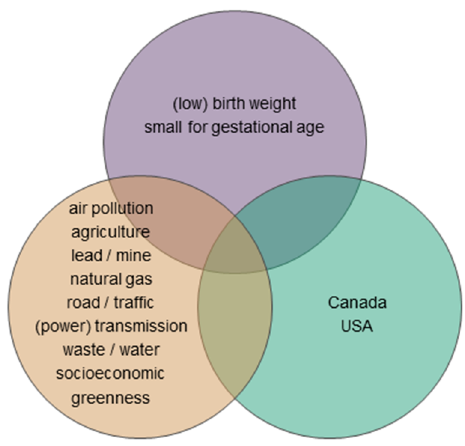
Figure 4. The keywords used in the literature search for studies associating outdoor environment and really small newborns are grouped by topic: health outcome (top), environmental variable (left), and geographic extent (right).